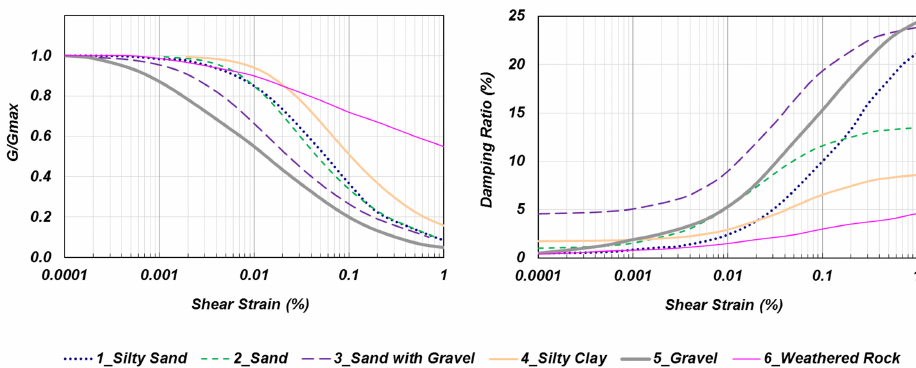
Fig. 3. Normalized shear modulus reduction and damping curves for site response analysis of